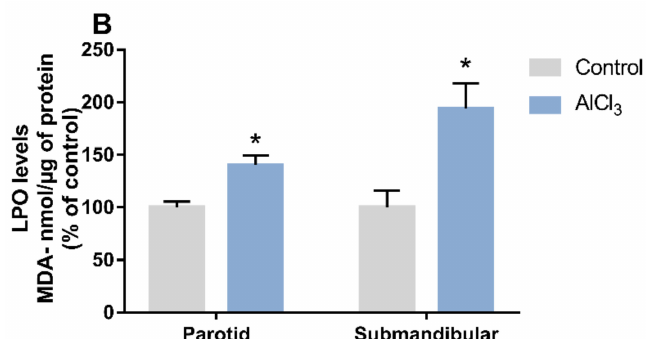
Figure 1. Effects of exposure to Aluminum Chloride (AlCl 3 ) (8.3 mg/kg/day) for 60 days on the oxidative biochemistry of salivary glands. ( A ) Antioxidant capacity against peroxyl radicals (ACAP). ( B ) Lipid peroxidation (LPO) levels. The results are expressed as the mean ± standard error of the mean (SEM). Student’s t -test, * p <